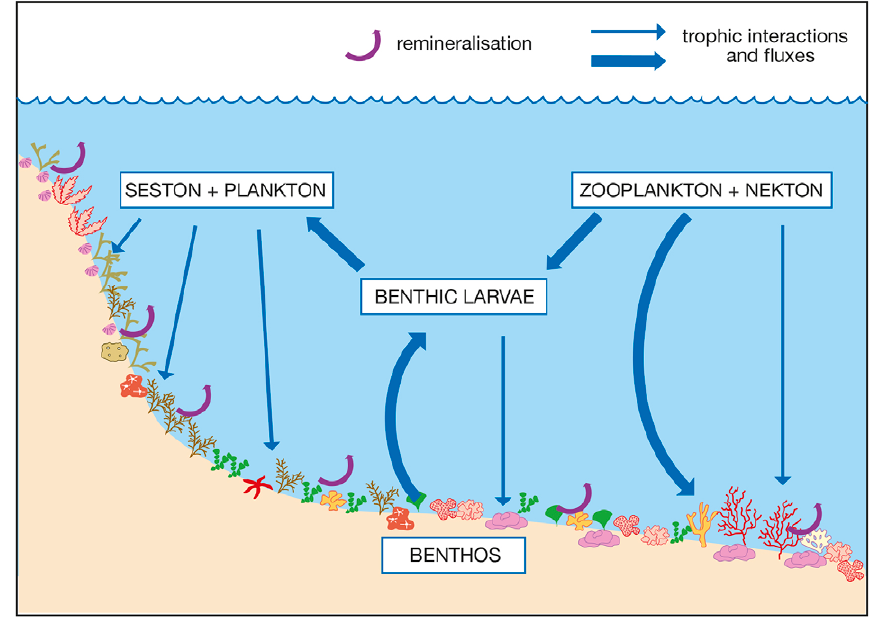
Fig. 5. – Trophic relationships between the benthic system and the water column system. From a classical point of view, the benthos exploits plankton by feeding on seston and plankton organisms that passively or actively reach the seafloor and by sending larvae to feed directly on plankton. A less considered relationship is the predation of zooplankton and nekton organisms on benthic larvae or directly on benthic animals (both sessile and motile). Another relationship of interest is the contribution of benthic activity to organic matter remineralization, enhancing the nutrient “way back” (purple